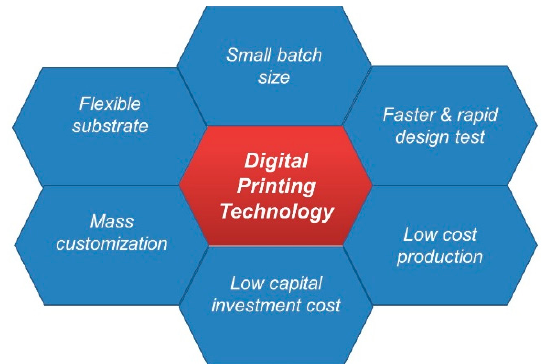
Figure 1. Main features of digital manufacturing technologies.